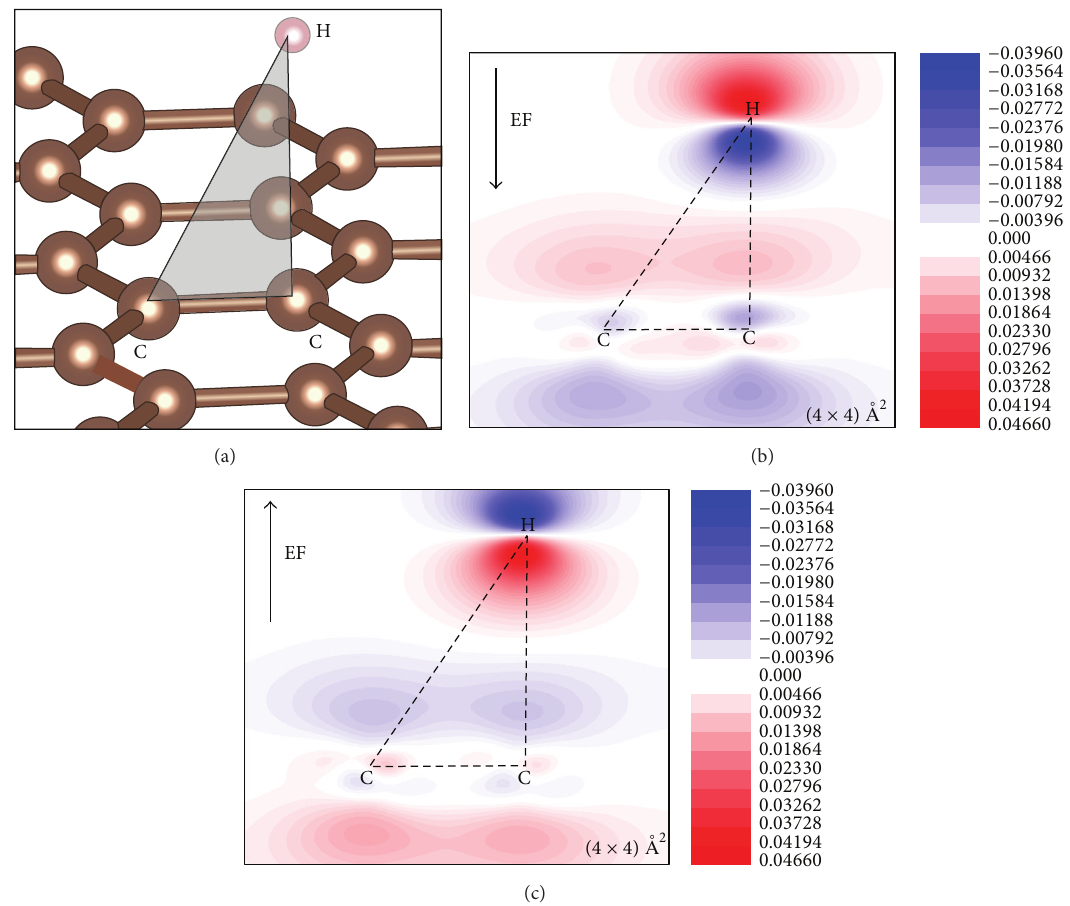
Figure 5: (a) Planar projection of the physisorption state; (b) charge density (e/˚A 3 ) resulting from the subtraction of H/G charge without EF to the systems with an EF of − 1.25 V/˚A intensity and (c) 0.75 V/˚A. The density changes are represented by a colored scale, with red and blue representing increases and decreases,